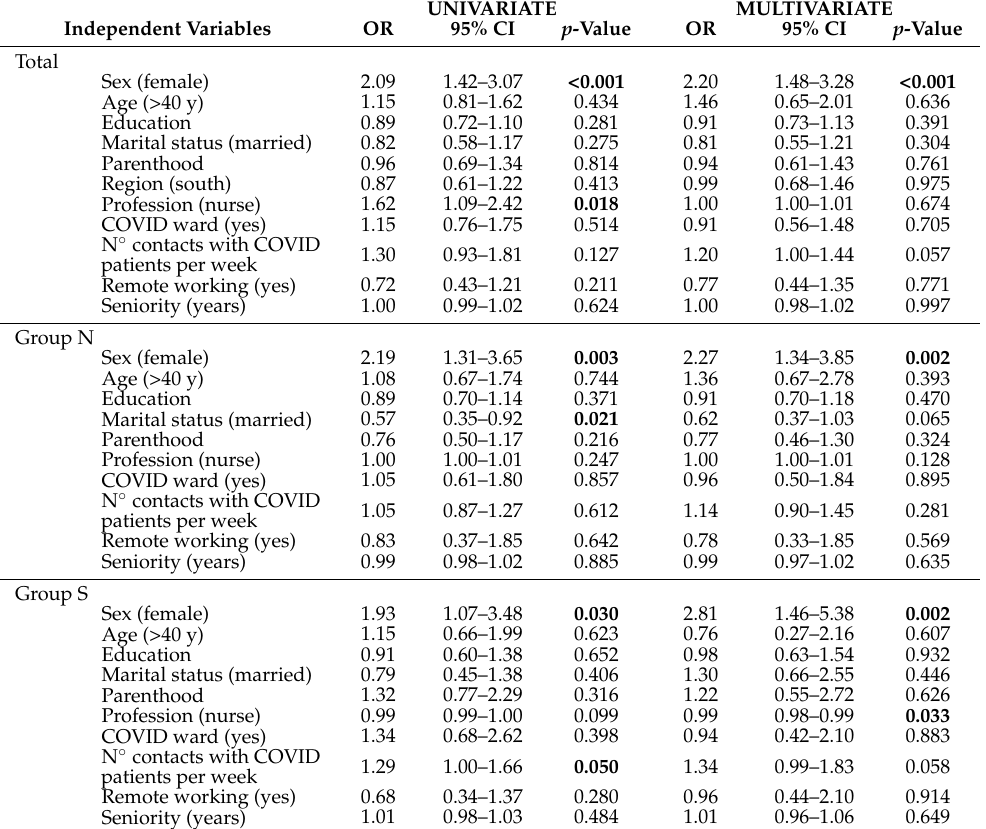
Table 5. Univariate and multivariate logistic regression for Athens Insomnia Scale in healthcare workers during the first wave of COVID-19 pandemic ( n =